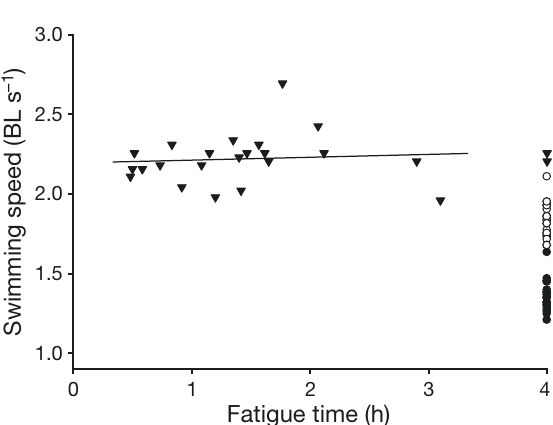
Fig. 1. Relative swimming speed (body length [BL] s −1 ) ver- sus time to fatigue during sustained swimming trials of At- lantic salmon. Points at the 4 h mark represent individual fish that completed the trial. Filled circles, open circles and triangles correspond to swimming speeds of 58, 78 and 97 cm s −1 respectively. Line represents a linear regression for fatigued fish ( y = 0.017 x + 2.194, R 2 = 0.006)